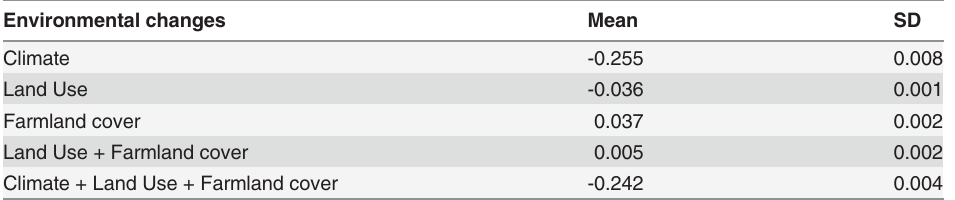
Table 2. Mean changes and associated standard deviation (SD) in regional abundance of all bird populations in response to changes in different environmental drivers: climate, land use (i.e. proportion of farmland habitats) and farmland cover